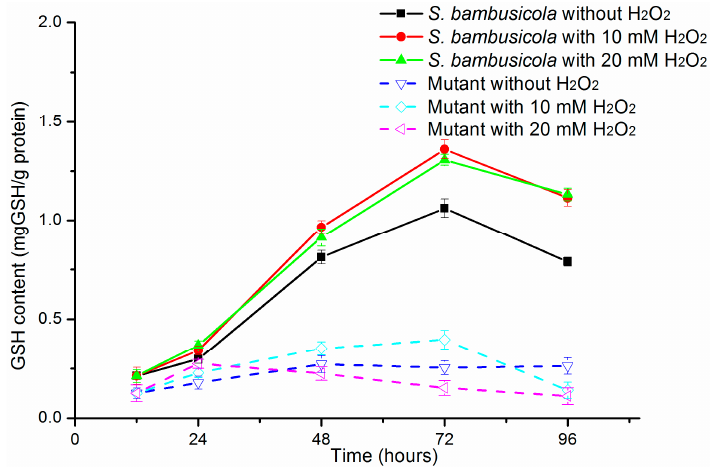
Figure 4. Effects of H 2 O 2 addition on GSH contents of the S. bambusicola and the mutant.